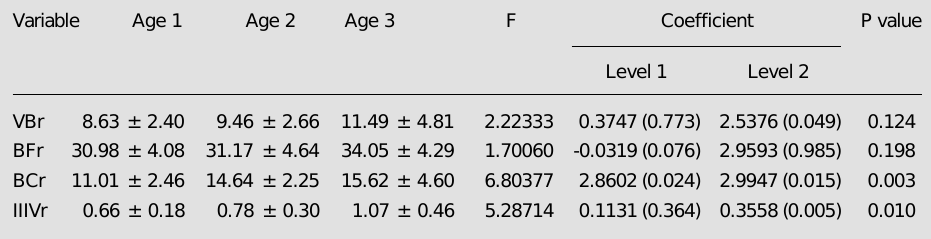
Table 2 - Brain ratios obtained for normal controls: age groups (MANOVA multivariate F-values, coefficients of each two-level factor comparison with significance, and P value for the 3 levels). Results are reported as means ± SD. Age 1: 50-60 years; age 2: 61-70 years; age 3: 71-90 years; VBr: ventricle brain ratio; BFr: bifrontal ratio; BCr: bicaudate ratio; IIIVr: third ventricle ratio; level 1: comparison between age 1 and age 2; level 2: comparison between age 3 and ages 1 and 2.